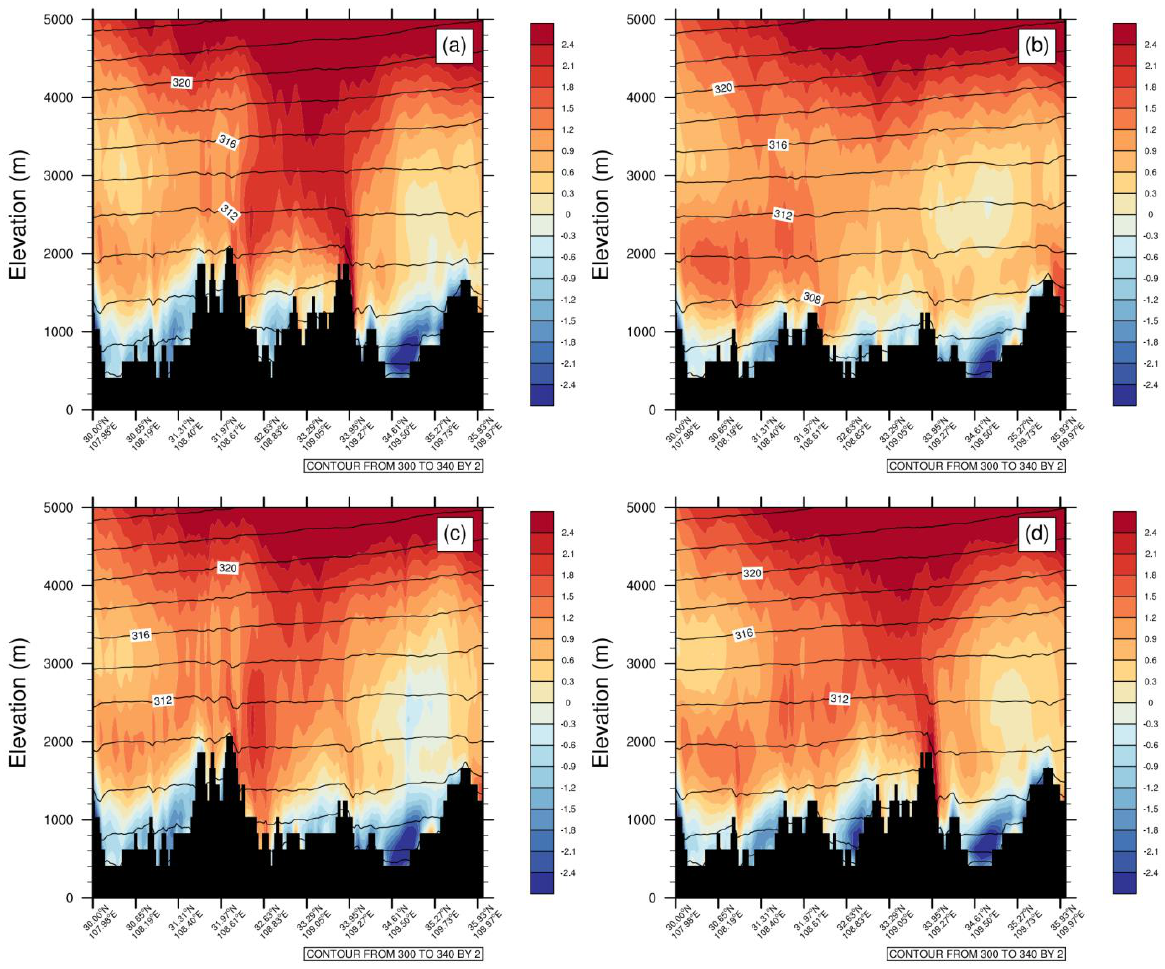
Figure 15. Vertical cross sections of vertical velocity of wind (m s −1 , color filling) and potential temperature (K, contour line) along the blue lines in Figure 1 of ( a ) CTRL, ( b ) LowQD, ( c ) LowQ, and ( d ) LowD on an average on 22:00 UTC (local time of 05:00, early morning) during the whole simulated time period.